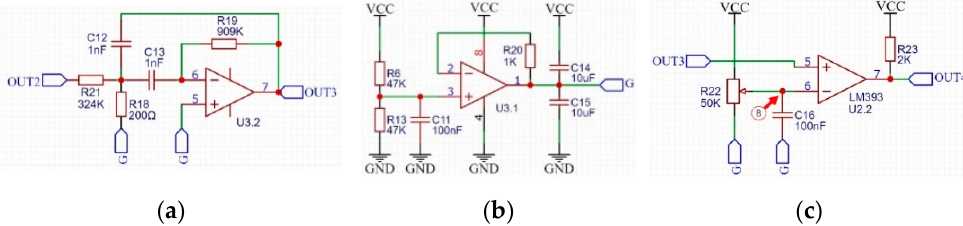
Figure 12. Signal processing circuit: ( a ) filter circuit and its output: OUT3; ( b ) analog ground voltage generation circuit and its output: G; ( c ) second comparator circuit and its output: OUT4.